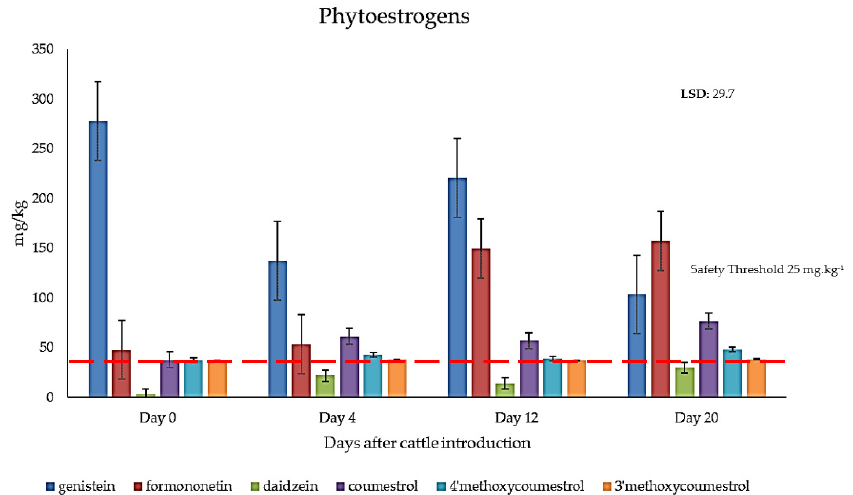
Figure 5. The average concentration of six phytoestrogens in mg · kg − 1 in field-grown lucerne pas-